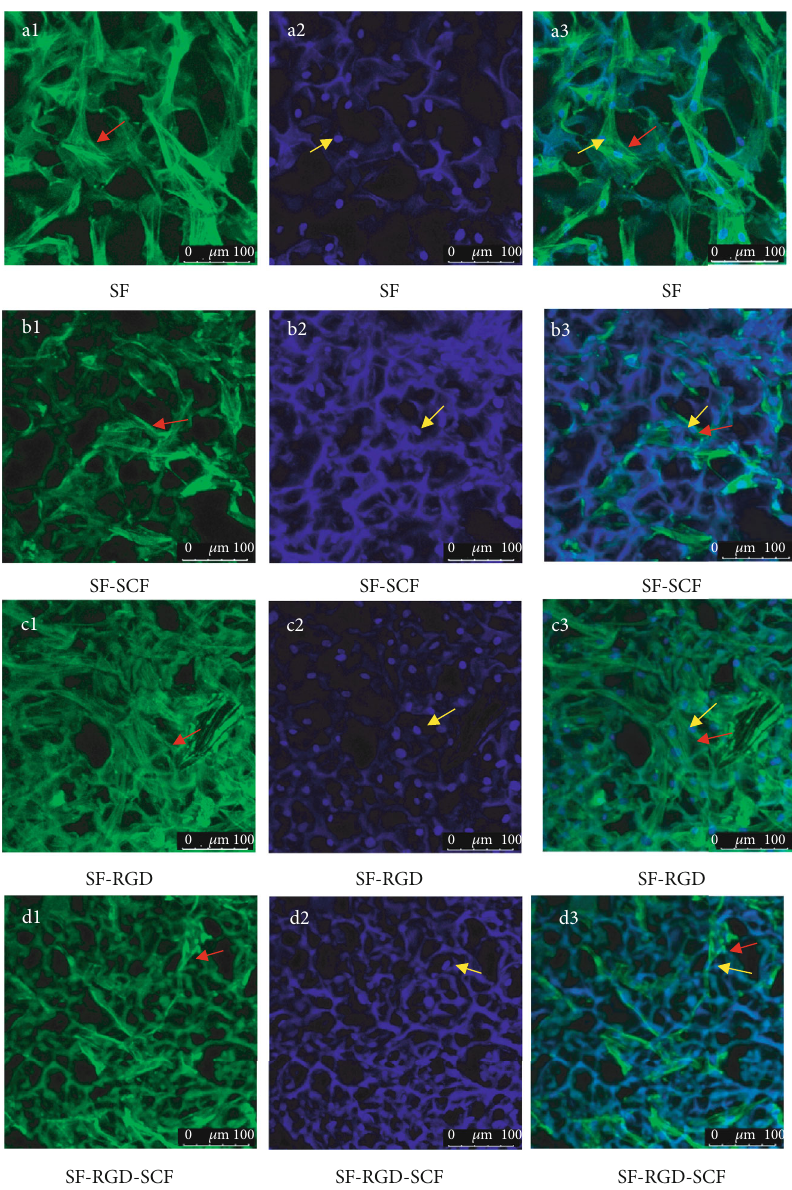
Figure 7: Laser scanning confocal microscopy images of cells on sca ff olds after 7 d seeding. Cell cytoskeletons were stained with Rhodamine Phalloidin (a1, b1, c1, d1). Cell nuclei were stained with Hoechst 33258 (a2, b2, c2, d2). Merged pictures of cell cytoskeletons and nuclei (a3, b3, c3, d3) (red arrows: cell cytoskeletons; yellow arrows: cell